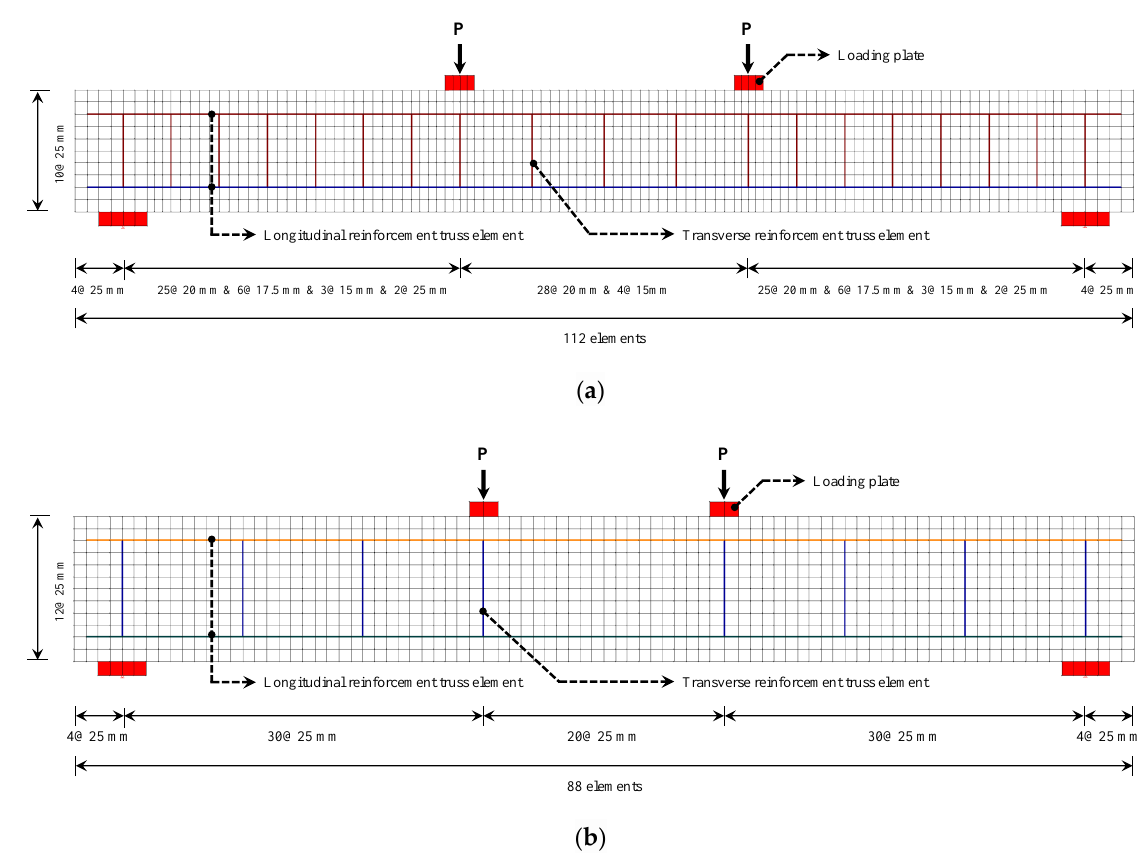
Figure 12. Finite element modeling of beams: ( a ) flexural beam and ( b ) shear beam.